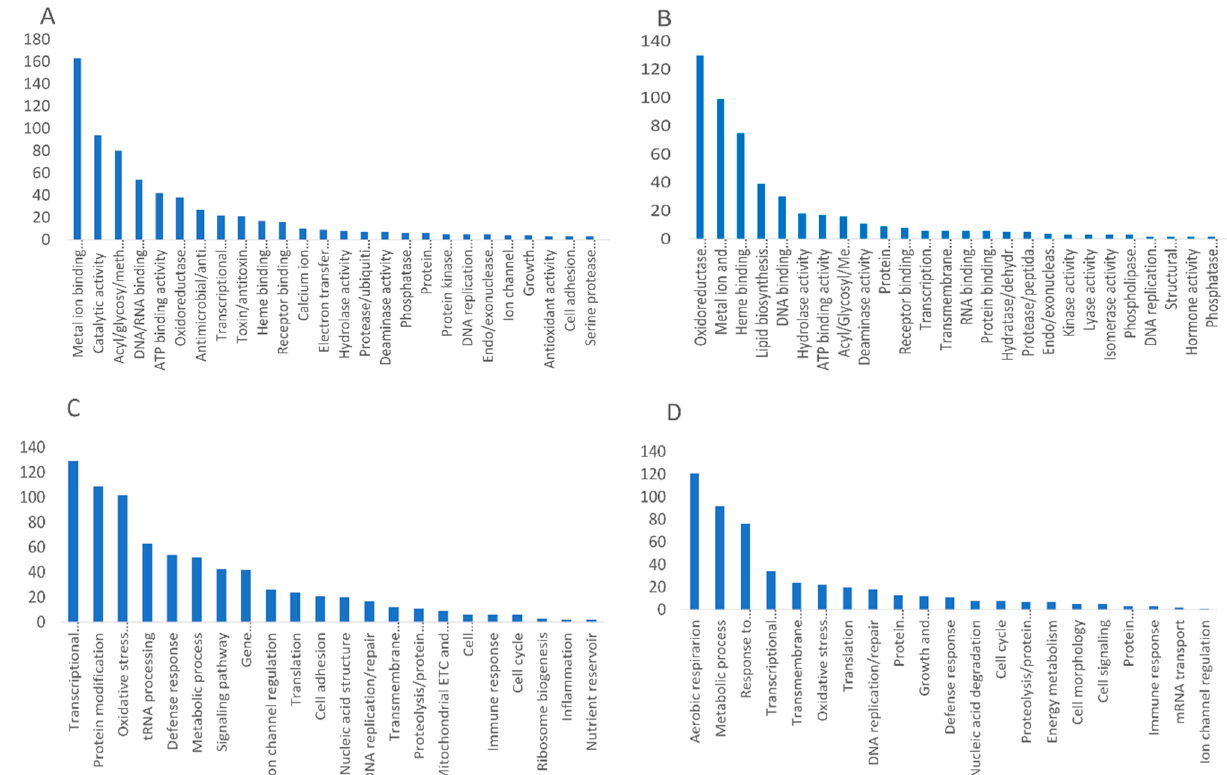
Figure 4. Categorization of proteins retrieved from an UniProtKB knowledgebase were performed in Gene Ontology. ( A , B ) Molecular function and ( C , D ) biological process terms and aligned with ( A , C ) AFP 14–20 and ( B , D ) GIP-9 segments of human AFP. Ranking was performed in order of decrease in number of unique genes in each category. Calculation of unique gene quantity was performed manually with no taken into account degree of a category significance.